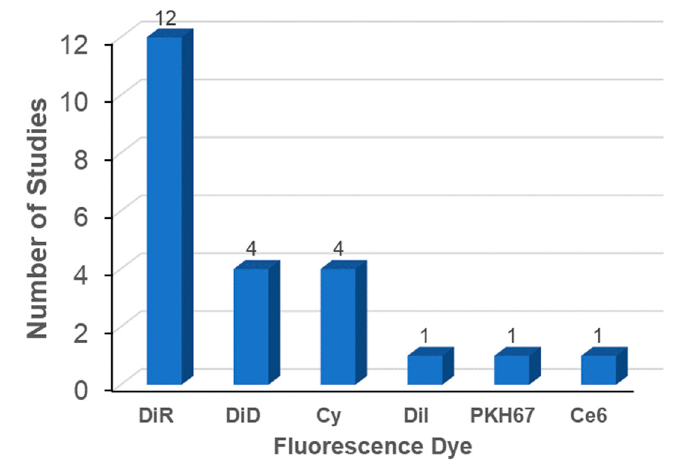
Figure 3. Fluorescent dyes used in biodistribution analysis of exosomes.